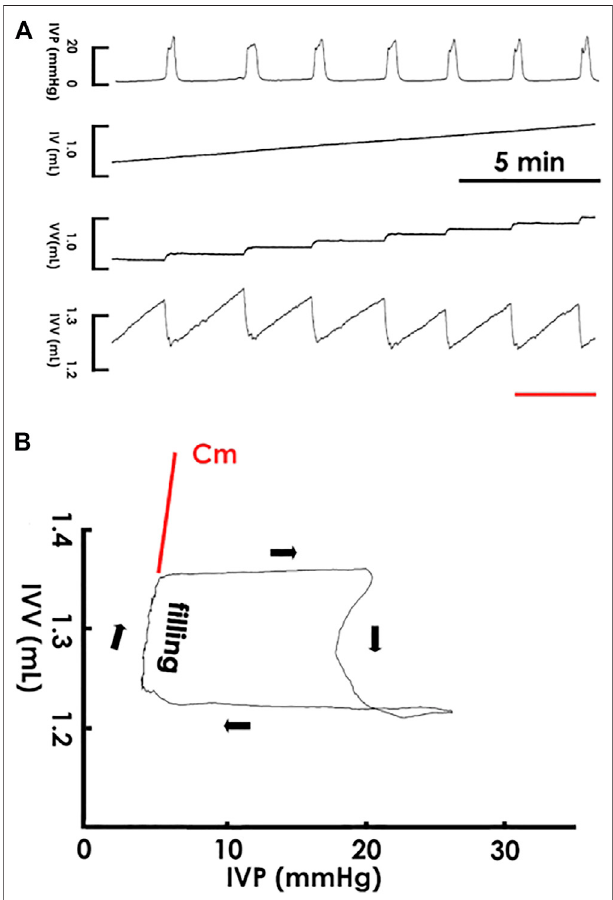
FIGURE 1 | Cystometry and pressure-volume analysis. (A) Cystometry showing that saline infusion (0.04 ml/min) into the bladder provokes rhythmic voiding contractions with a constant frequency as well as uniformed peaks of IVP and fl uctuations of intra-vesical volume (IVV). The red bar at the bottom marks the cycle displayed in the pressure-volume analysis. (B) A pressure-volume analysis established by plotting IVV against IVP. The data trajectory moves clockwise and shapes an enclosed loop. The left bolder of the loop represents the fi lling phase, and the instantaneous slope of the trajectory re fl ected the dynamic compliance at speci fi c points of the fi lling phase. The slope of the regression line of the fi lling trajectory denotes the mean compliance (Cm) of a loop. IV, infused volume; VV, voided